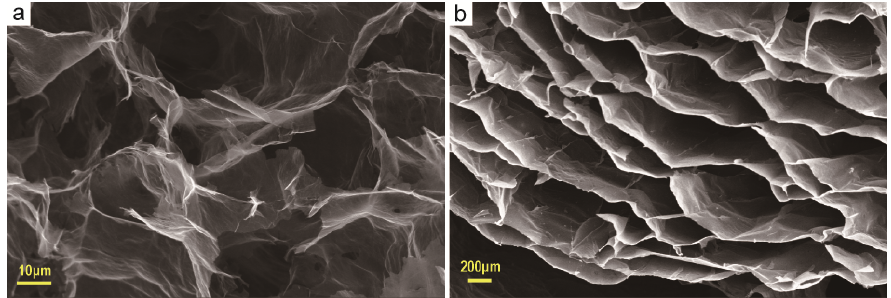
Figure 1. Electron micrographs of internal pore characteristics of graphene aerogels prepared by different methods ( a ) without directed freezing; ( b ) directed freezing.